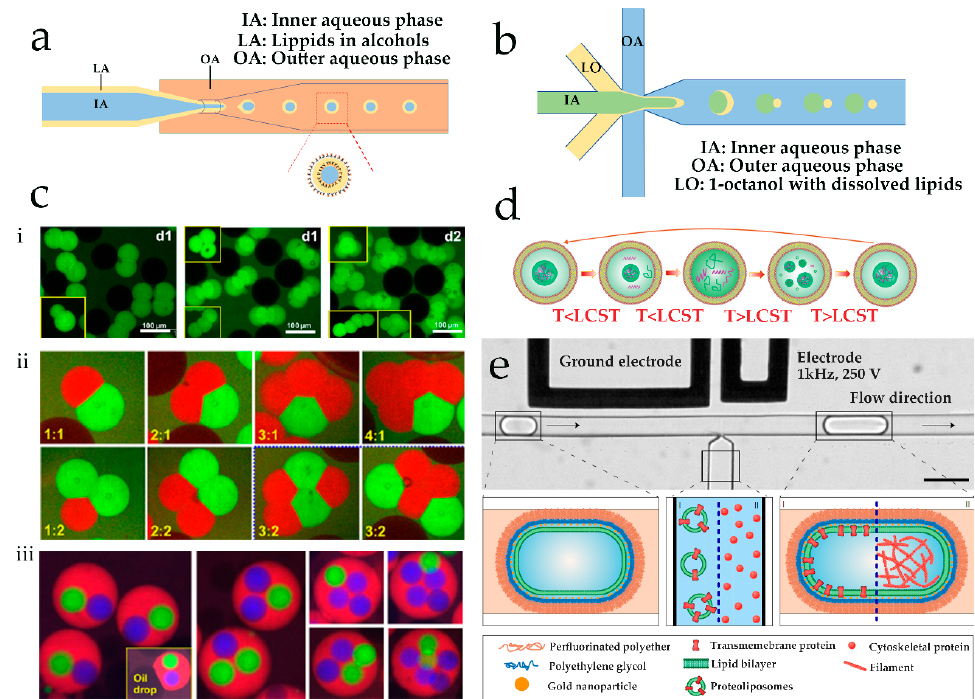
Figure 2. Droplet emulsion-based method used to fabricate liposomes. ( a ) Schematic of a microfluidic double emulsion process; ( b ) an octanol-assisted liposome assembly (OLA) in a microfluidic device; ( c ) liposomes with various structures prepared by microfluidic double emulsions; ( i , ii ) multicompartment liposomes with uniform ( i ) or distinct components ( ii ) (reprinted with permission from [43] Copyright (2016) American Chemical Society); ( iii ) vesosomes with different number of liposomes in their core (reprinted with permission from [44] Copyright (2017) American Chemical Society); ( d ) thermal dynamics of the membrane-less organelle-like compartment in liposomes (reprinted with permission from [45]); and ( e ) schematic process for incorporating biomolecules into droplet-stabilized giant unilamellar vesicles (dsGUVs) through pico-injection droplet microfluidic technology, scale bar: 50 µ m (reprinted with permission from